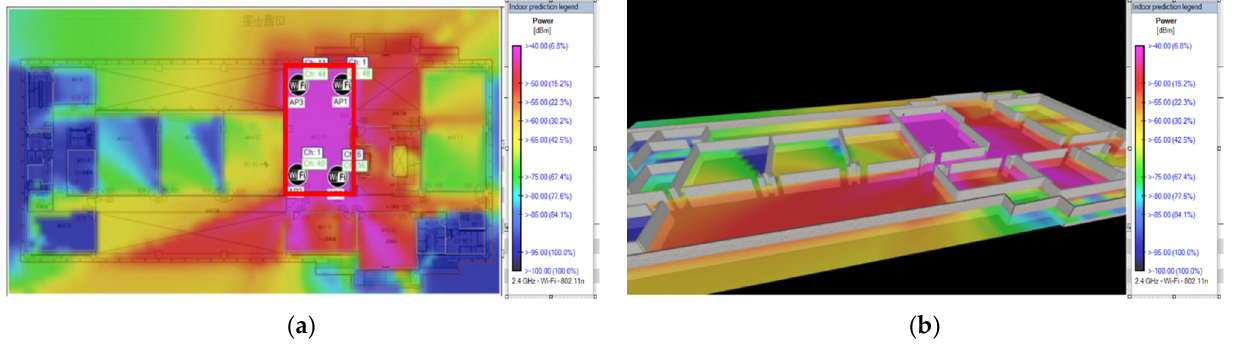
Figure 2. RSSI simulated by iBwave. ( a ) Simulated Wi-Fi 2.4 GHz RSSI for all APs in an area of interest using iBwave; ( b ) 3D modelling for simulated Wi-Fi 2.4 GHz RSSI of all APs in an area of interest using iBwave.